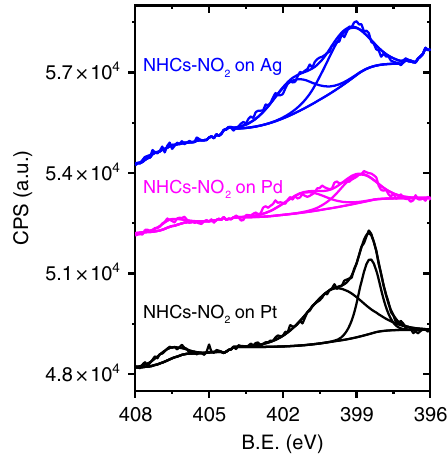
Fig. 7 N1 s XPS measurements of EC-deposited NO 2 -NHCs on various metal fi lms. N1 s XPS signals of EC-deposited NO 2 -NHCs on Pt, Pd, and Ag fi lms (black-, magenta- and blue-colored spectra,